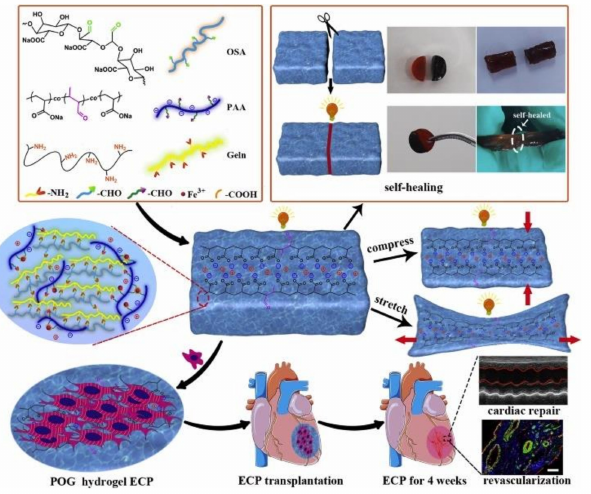
Figure 6. Schematic illustration about the fabrication of the tunable self-healing POG1 hydrogel and its application in myocardial infarction repair. Adapted with permission [88]. Reproduced with permission from Song, X, Biomaterials; published by Elsevier, 2021.